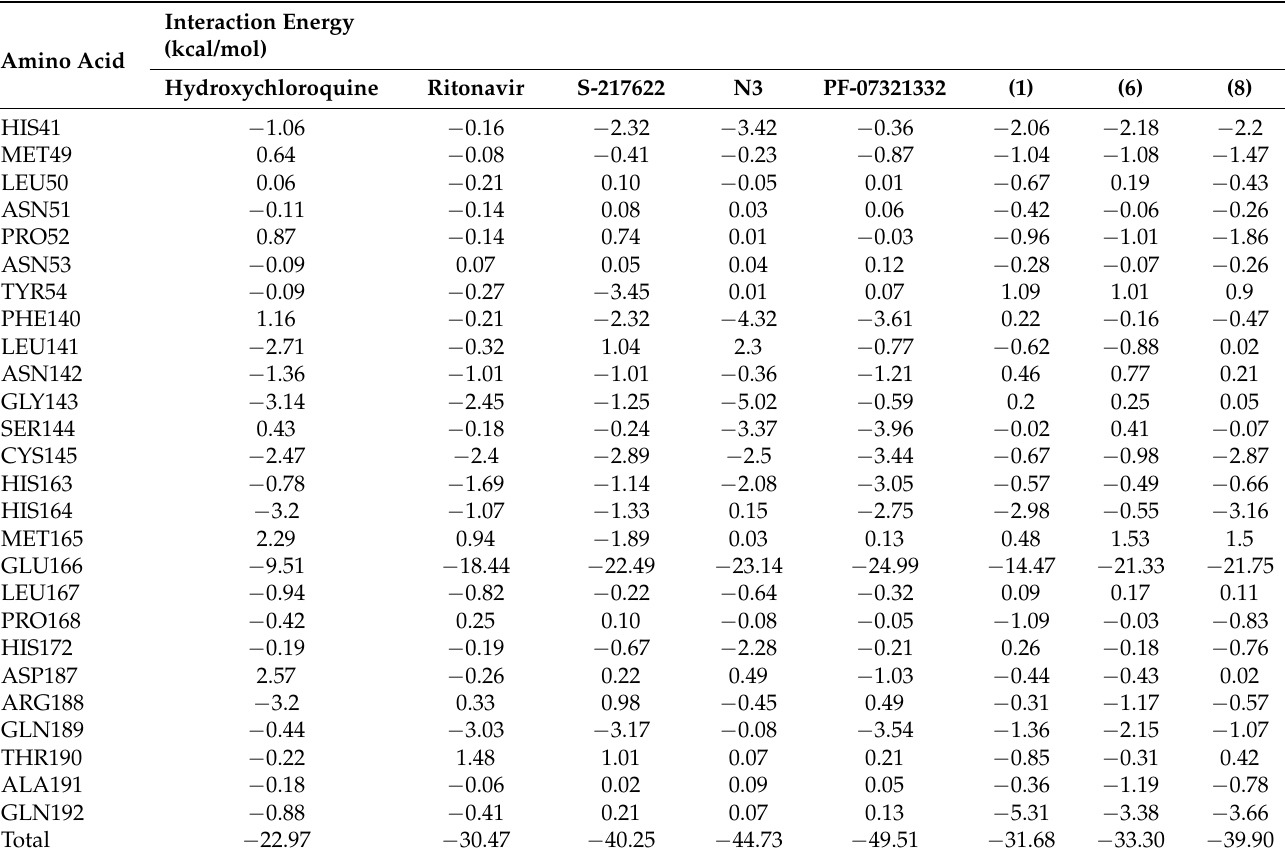
Table 4. Interaction energies of ligands with the individual amino acid residues of M pro , calculated at the B3LYP/6-31G (d,p)